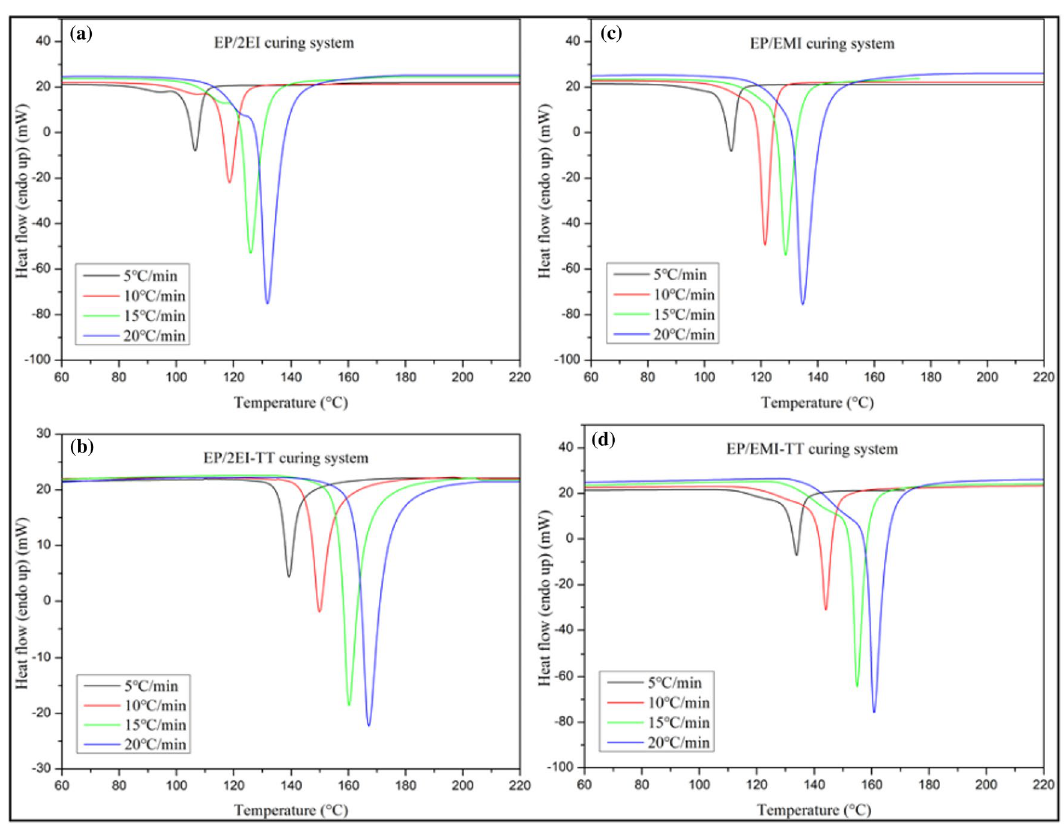
Fig. 7 DSC curves of the EP blends tested with the heating rate of 5, 10, 15, and 20 °C/min for 2EI, EMI, 2EI-TT and